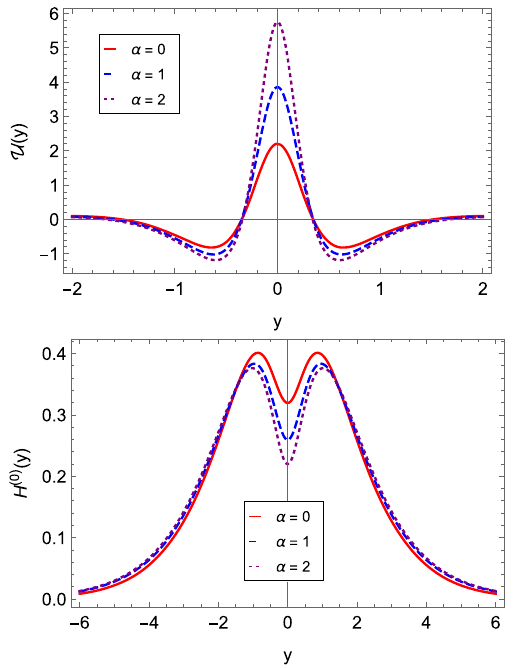
Fig. 12 Stability potential U ( y ) (top panel) and graviton zero-mode H ( 0 ) ( y ) (bottompanel)forthenumericalsolutionsobtainedinSect.3.1, with ϕ 0 = − 1, U 0 = k = φ 0 = 1, for different values of